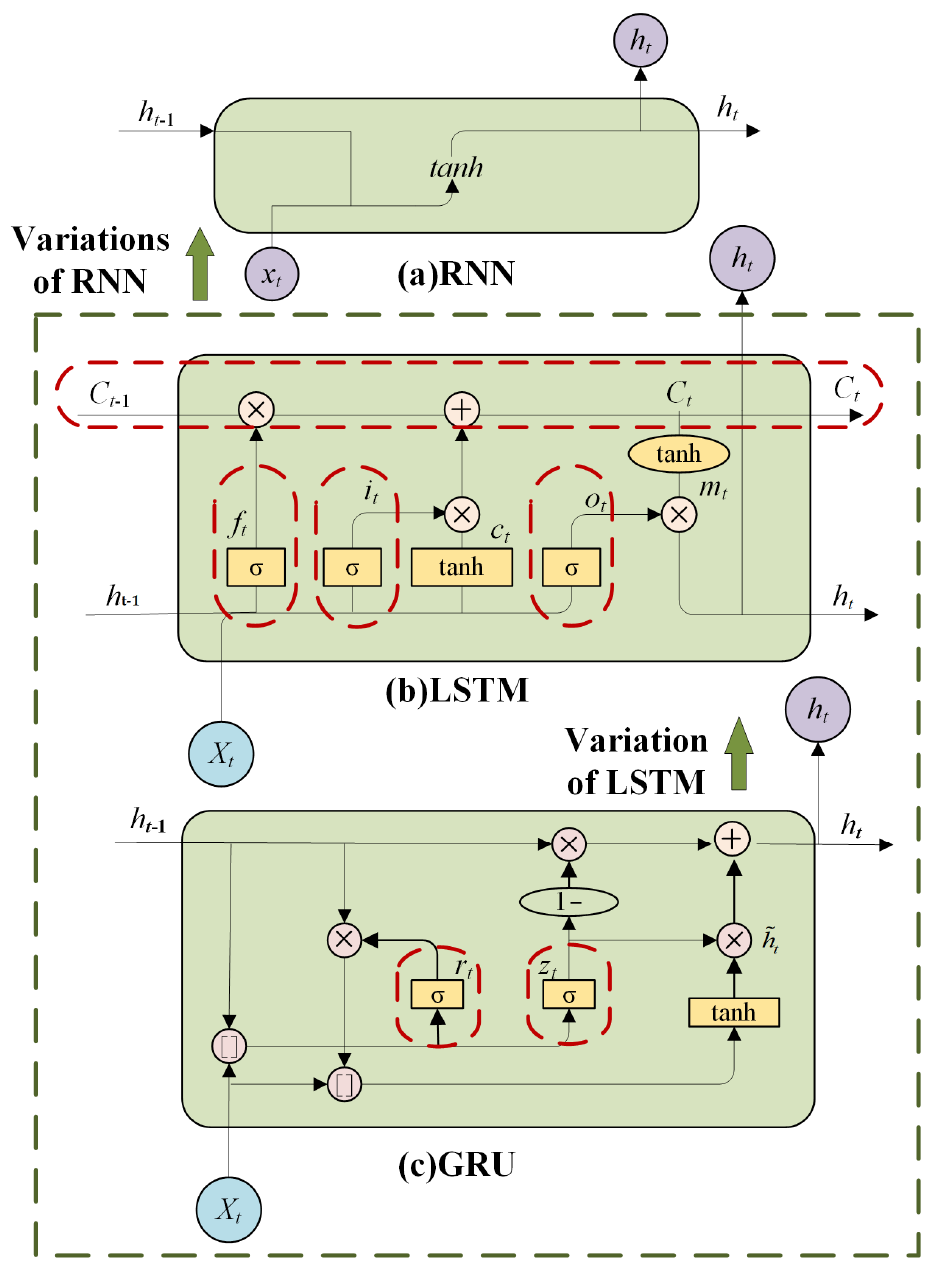
Figure 4. Comparison of RNN, LSTM, and GRU neural network structures.